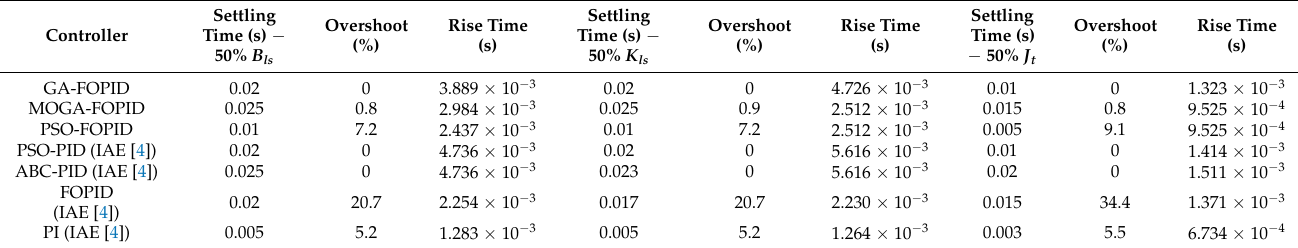
Table 9. The effects of system parameter uncertainties on controller